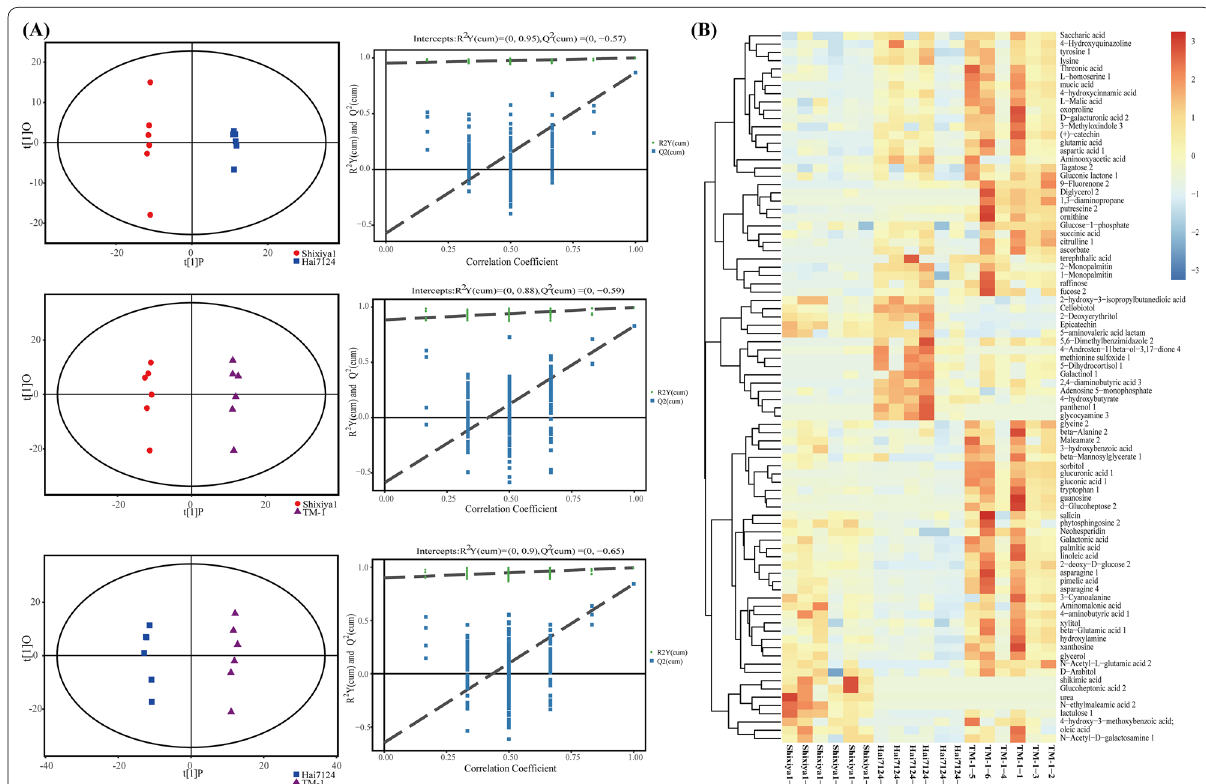
Fig. 1 OPLS-DA analysis and heatmap of hierarchical clustering analysis of differential metabolites for three cotton cultivars. A Score scatter plot of OPLS-DA between each two cultivars. B The differential metabolites from three cotton cultivars used to draw the heatmap of hierarchical clustering analysis (HCA). The horizontal axis and vertical axis represent the different cottonseed samples and different metabolites, respectively. Each relative metabolite content is listed in Additional file 10: Table